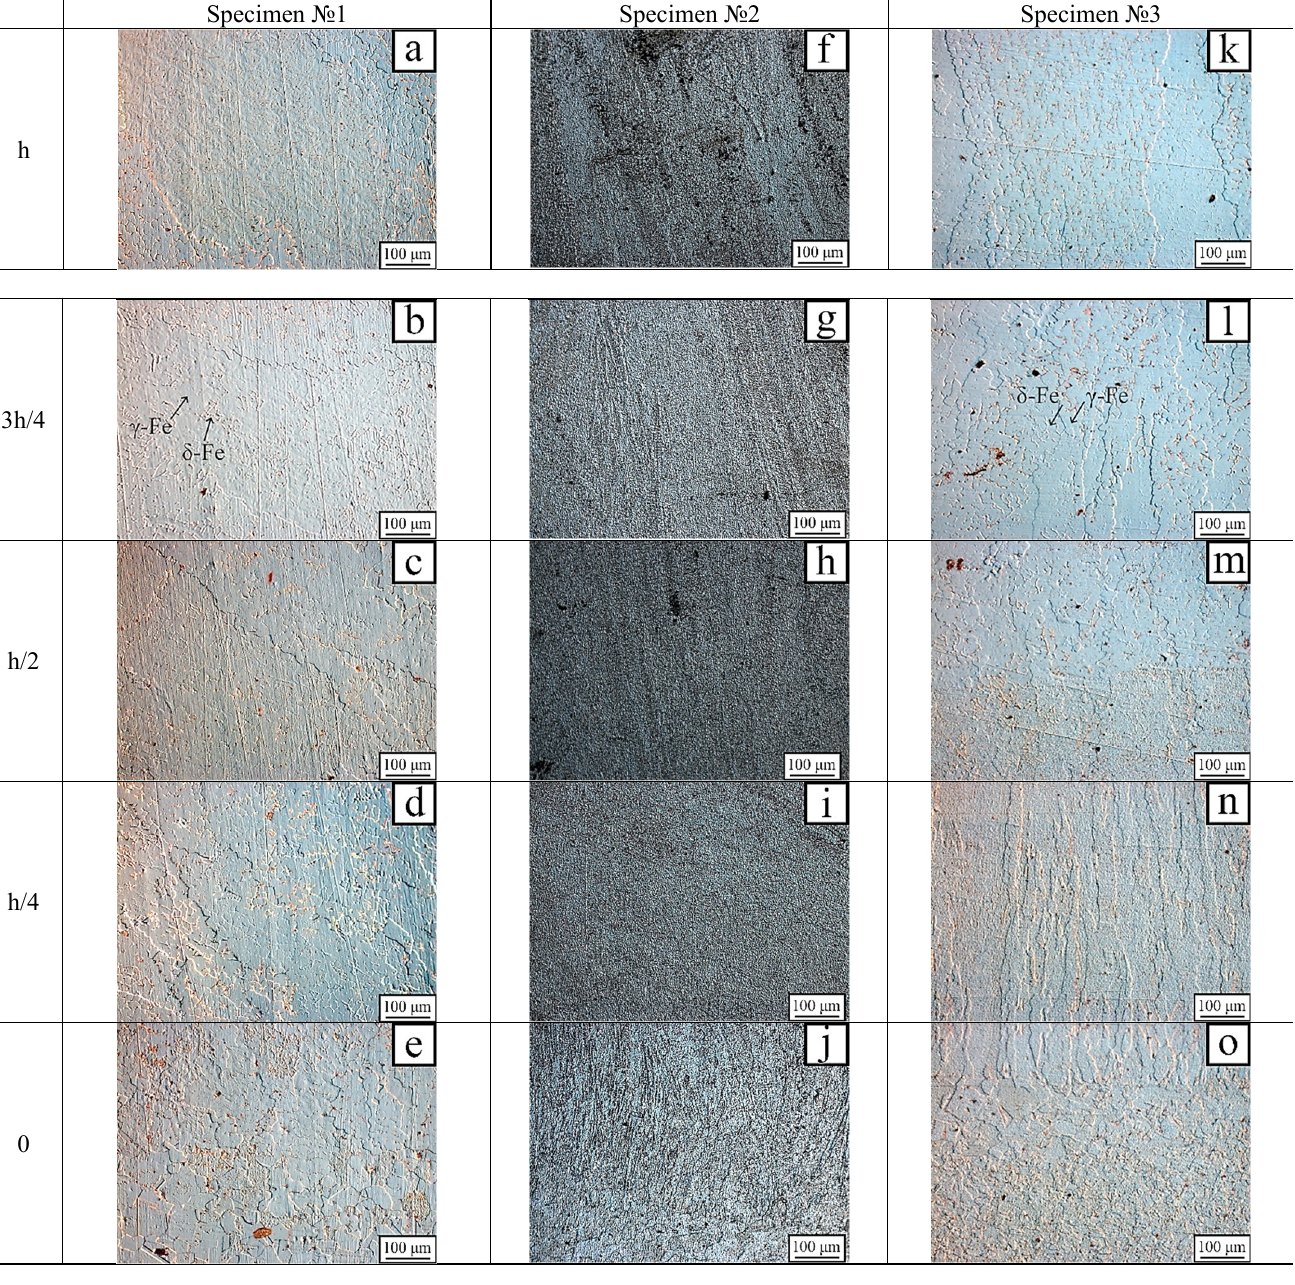
Figure 7. Bright-field images of structures along the axis (L = l/2) of cross-sections of specimens: ( a – e )—specimen № 1, ( f – j )—specimen № 2, ( k – o )—specimen № 3.